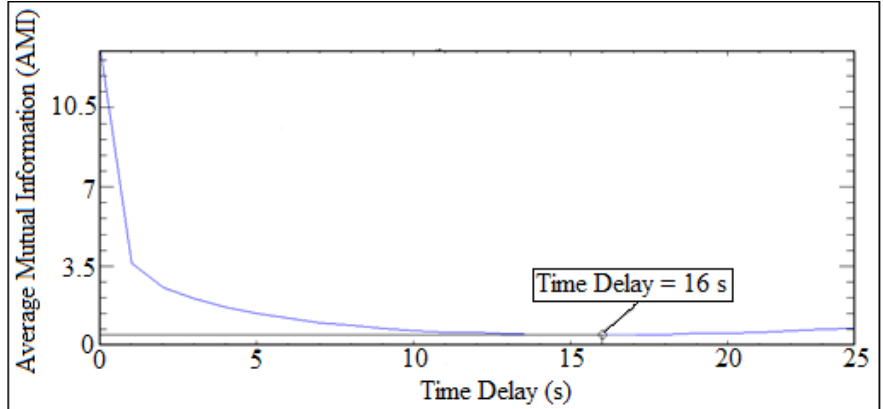
Figure 20. Time delay of experiment test.